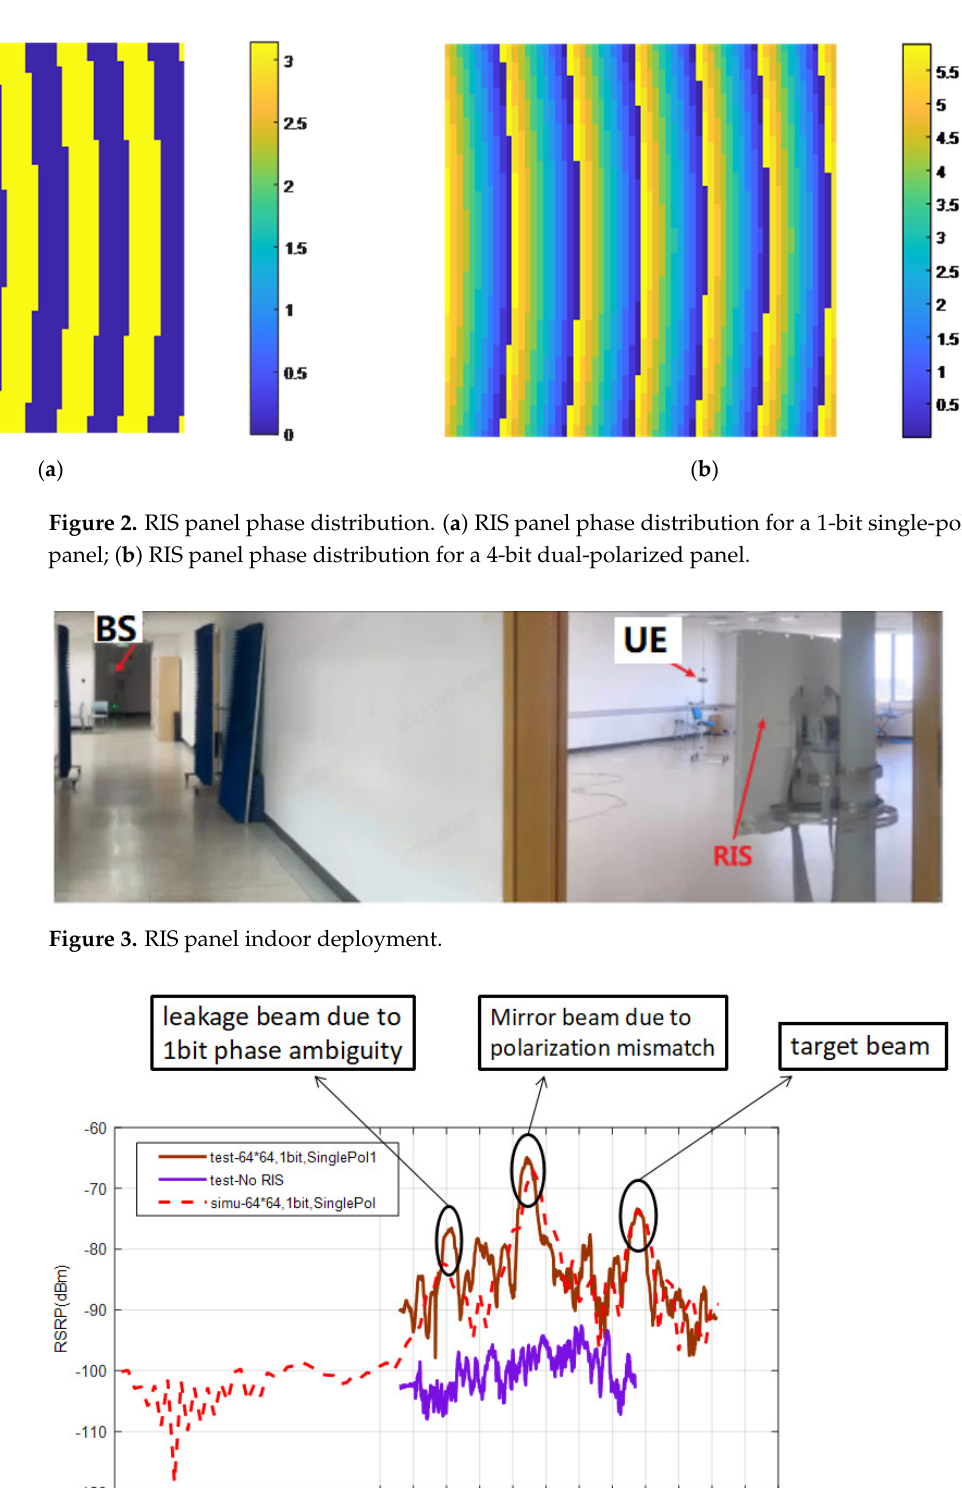
Figure 5. Comparison of the measured and simulated results of the 4-bit dual-polarized panel. From the simulation parameters, the incident angle was 32 degrees and the reflection angle was 48 degrees. Although some of the derived beams were filtered by deploying absorbers in the environment, there were still some reflected waves reflected in the meas- ured results. In Figure 4, it can be seen that the 1-bit phase ambiguity led to beam leakage